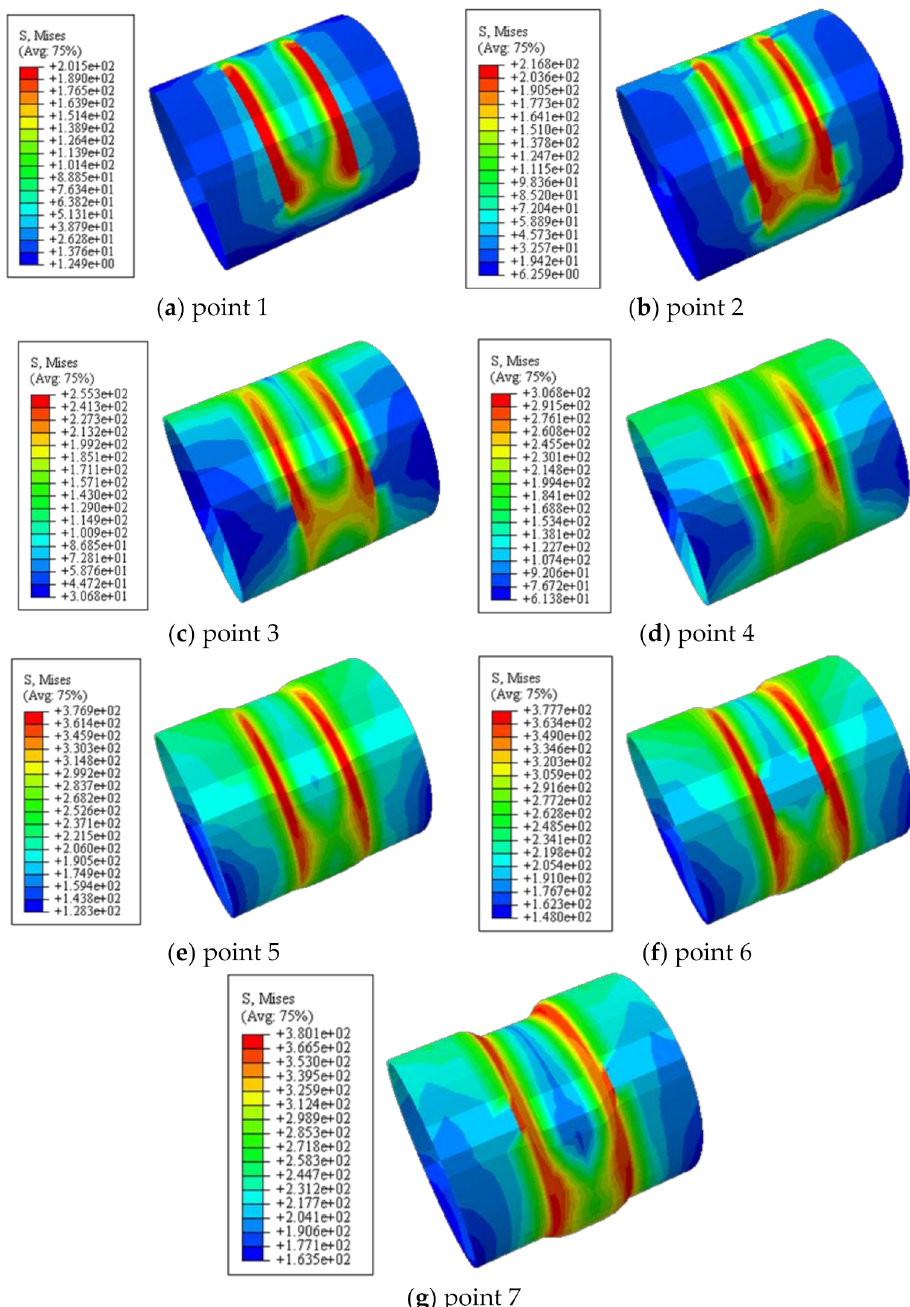
Figure 13. The longitudinal distribution of Mises stress in steel